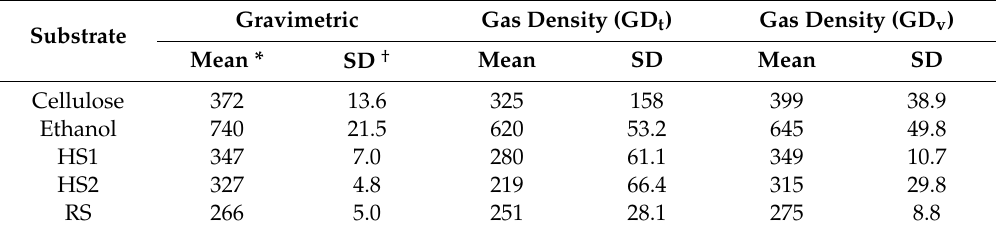
Table 3. Gas density and gravimetric estimates of BMP (all in mL g − 1 ) for four substrates from Experiment 1B, based on measurements made on the same set of bottles. Leakage was observed for all substrates, resulting in biased and variable GD t results. The duration was 21 days for all bottles, and n = 3 bottles for each